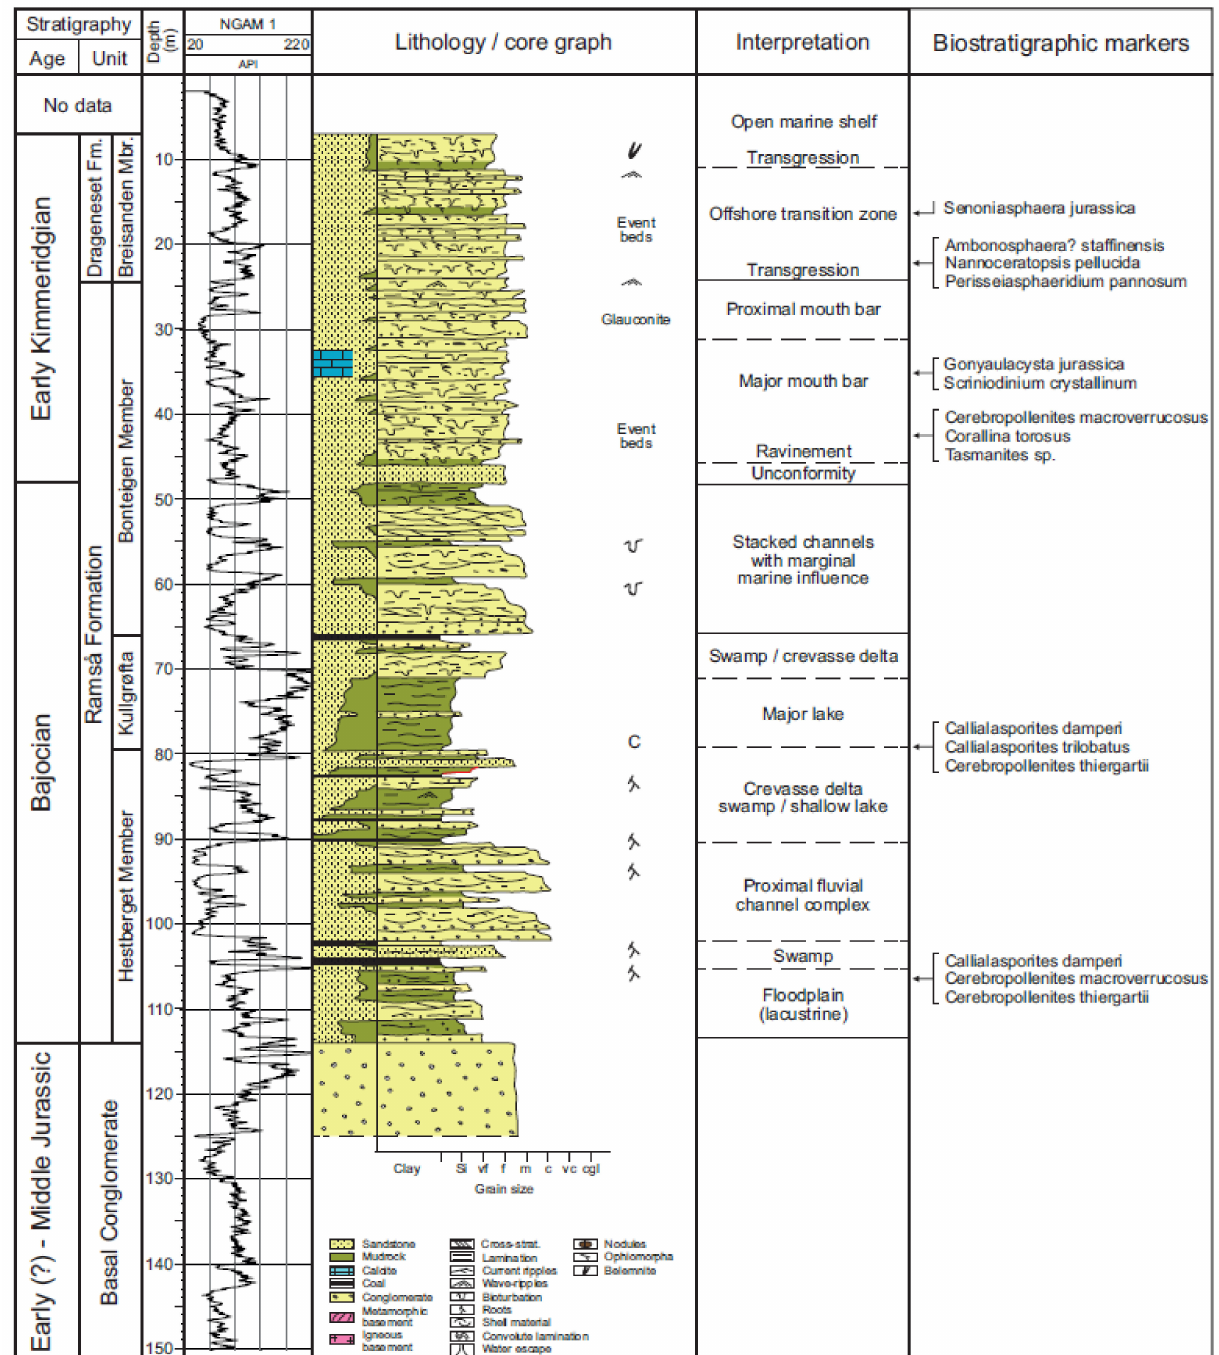
Figure 3. Lithological and gamma log of Bh 1, with interpretations of ages and depositional environments of the formations and members (Based on Bönner et al.